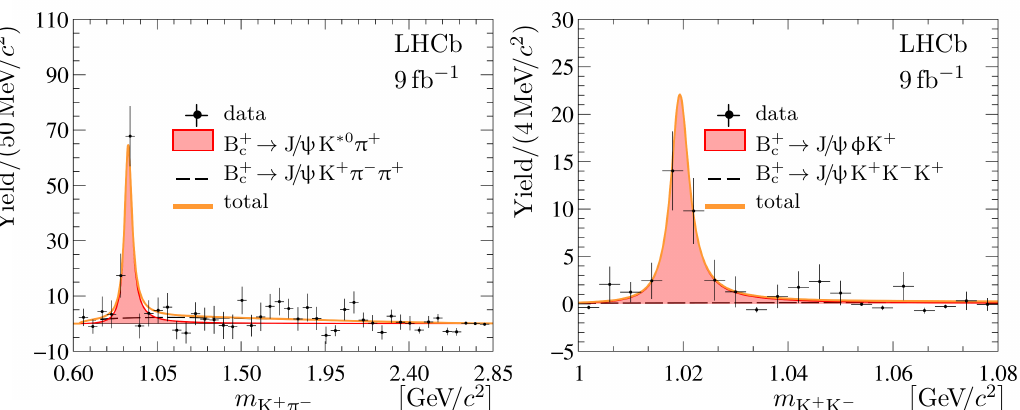
Figure 5 . Background-subtracted mass distributions of (left) K + (cid:25) − pairs for the se- lected B + → J / K + (cid:25) − (cid:25) + candidates and (right) K + K − combinations for the se- c lected B + → J / K + K − K + candidates. The K + K − mass spectrum is fitted in the full accessible c K + K − mass region, m < 2 . 2 GeV/ c 2 . For better visibility, only a low-mass part of the spec- K + K − trum is